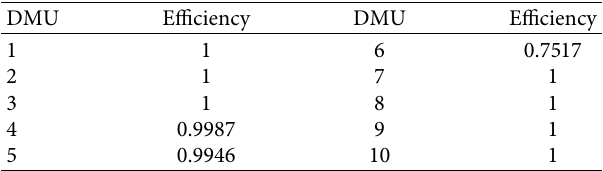
Table 3: Efficiency measurement using model equation (8) for 10 cement companies.